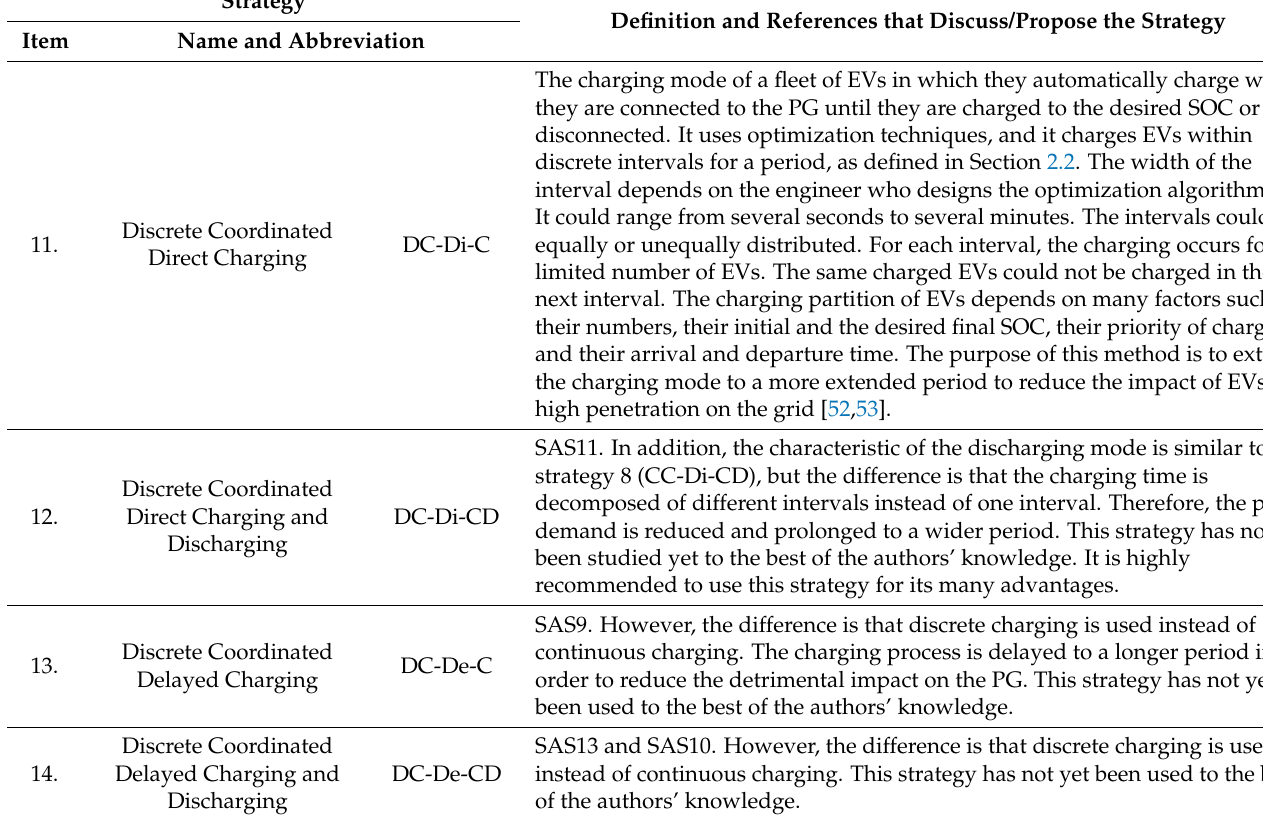
Table 3. Definitions of Discrete Coordinated Charging Strategies of EV.